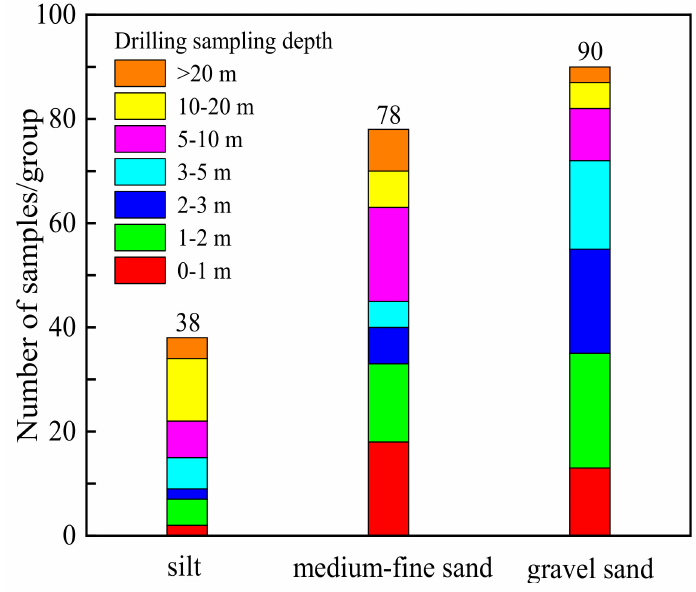
Figure 1. Sampling depth of sand